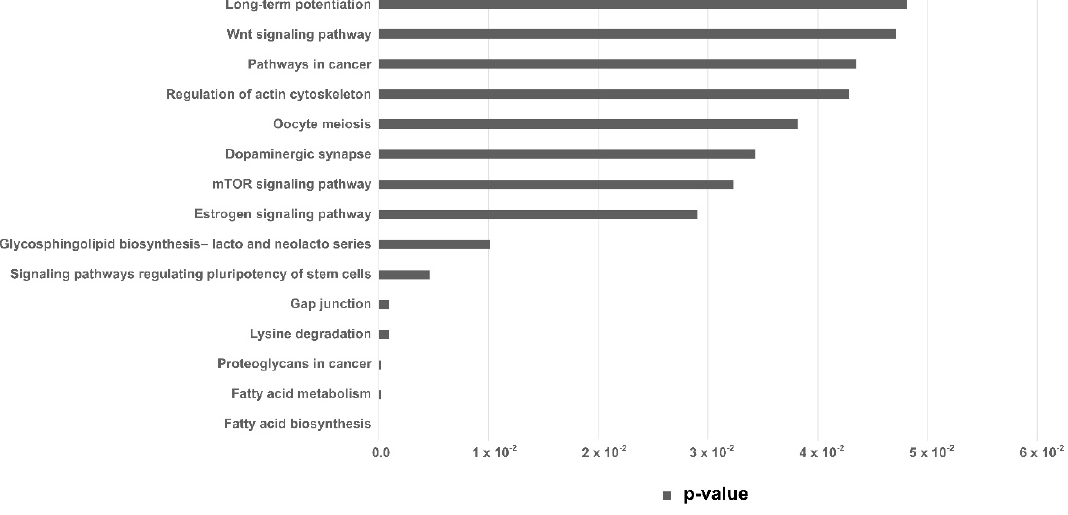
Figure 4. KEGG pathways analysis. KEGG pathways predicted from the miRNAs upregulated in EVs secreted by arrested embryos at 8–16 cells. Horizontal bar indicates p -value.